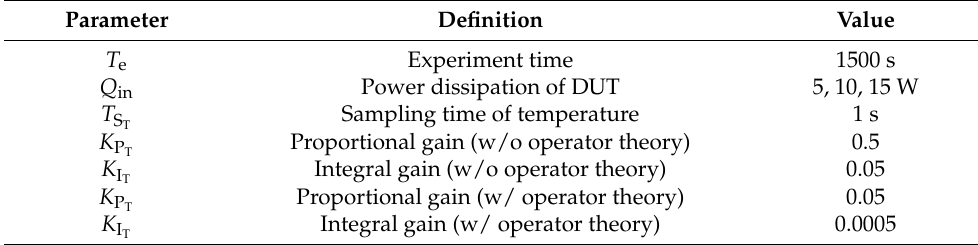
Table 6. Experiment